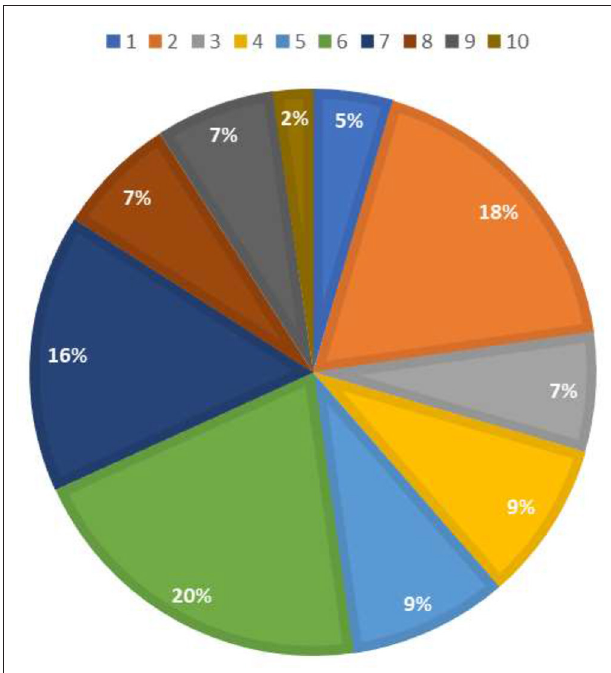
FIGURE 5 | Percentage of studies in the period 2018–2021 by classification category. Note: 1 = C1. Research in gamification; 2 = C2. Research in sport; 3 = C3. Research in genetics; 4 = C4. Research in psychological therapies; 5 = C5. Research in human behavioral analysis in natural contexts; 6 = C6. Research in non-human behavioral analysis in laboratories; 7 = C7. Research in human behavioral analysis in educational contexts; 8 = C8. Research in human behavioral analysis with pharmacological consequences; 9 = C9. Research in human behavioral analysis in laboratories; 10 = C.10. Research in human behavioral analysis in work contexts.